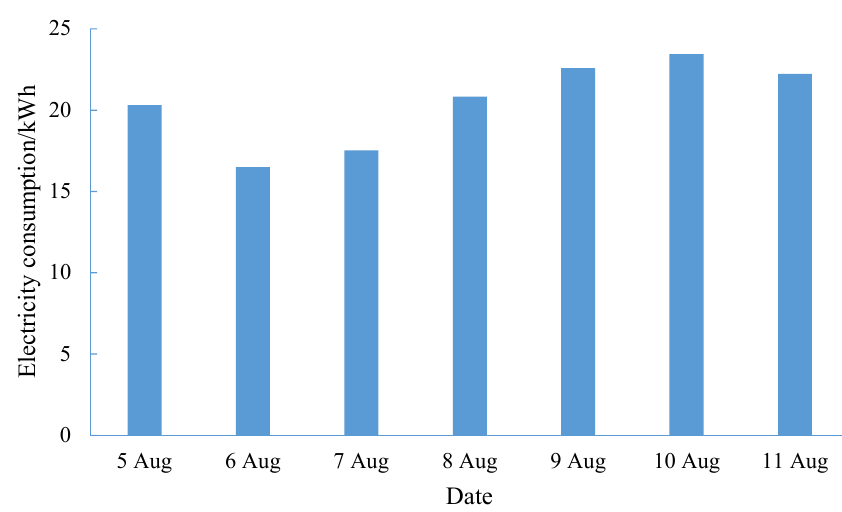
Figure 3. Household electricity composition analysis.